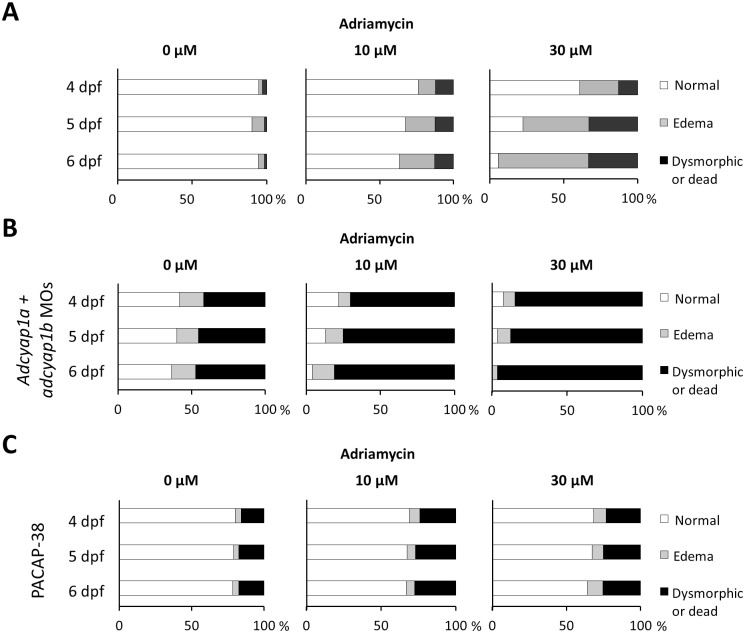
PACAP morpholino suppression and PACAP-38 rescue in adriamycin exposed embryos.(A) Approximately 100 embryos exposed to adriamycin (0, 10 or 30 μM) in the swimming water (no injections), were live-screened at 4, 5 and 6 dpf and assigned to a phenotype category. (B) Approximately 100 embryos injected with PACAP morpholinos (adcyap1a and adcyap1b, 100 μM) were exposed to adriamycin (0, 10 or 30 μM) and then live-screened at 4, 5 and 6 dpf. PACAP morpholinos had a devastating effect on survival and morphology of the adriamycin exposed embryos. (C) Approximately 100 embryos injected with the human PACAP-38 peptide (5 μM) were exposed to adriamycin (0, 10 or 30 μM) and then live-screened at 4, 5 and 6 dpf. Human PACAP-38 could rescue the nephrotic phenotype in zebrafish with adriamycin exposure especially with the higher concentration (30 μM).